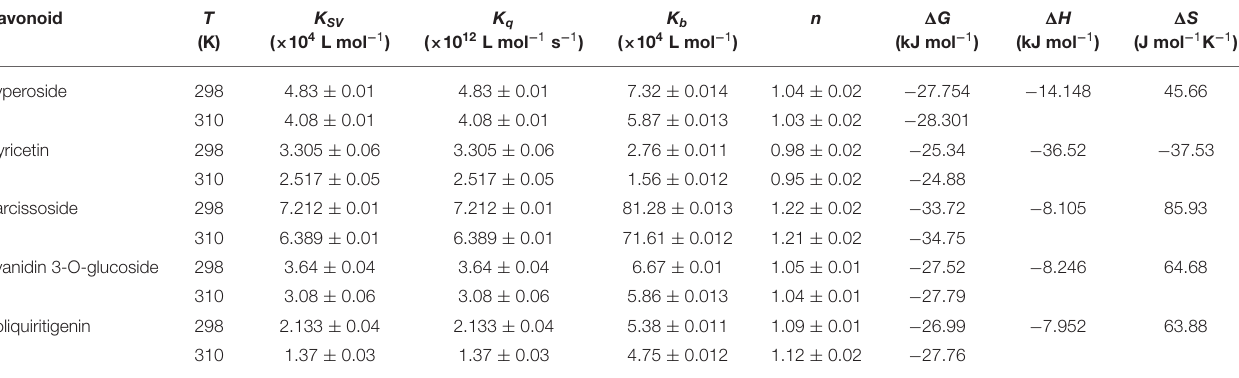
TABLE 3 | Quenching constants ( K sv ), quenching rate constant ( K q ), binding constants ( K b ), number of binding sites ( n ) and thermodynamic parameters for interactions between DPP-4 and myricetin, hyperoside, narcissoside, cyanidin 3-O-glucoside, isoliquiritigenin at different temperatures. Flavonoid